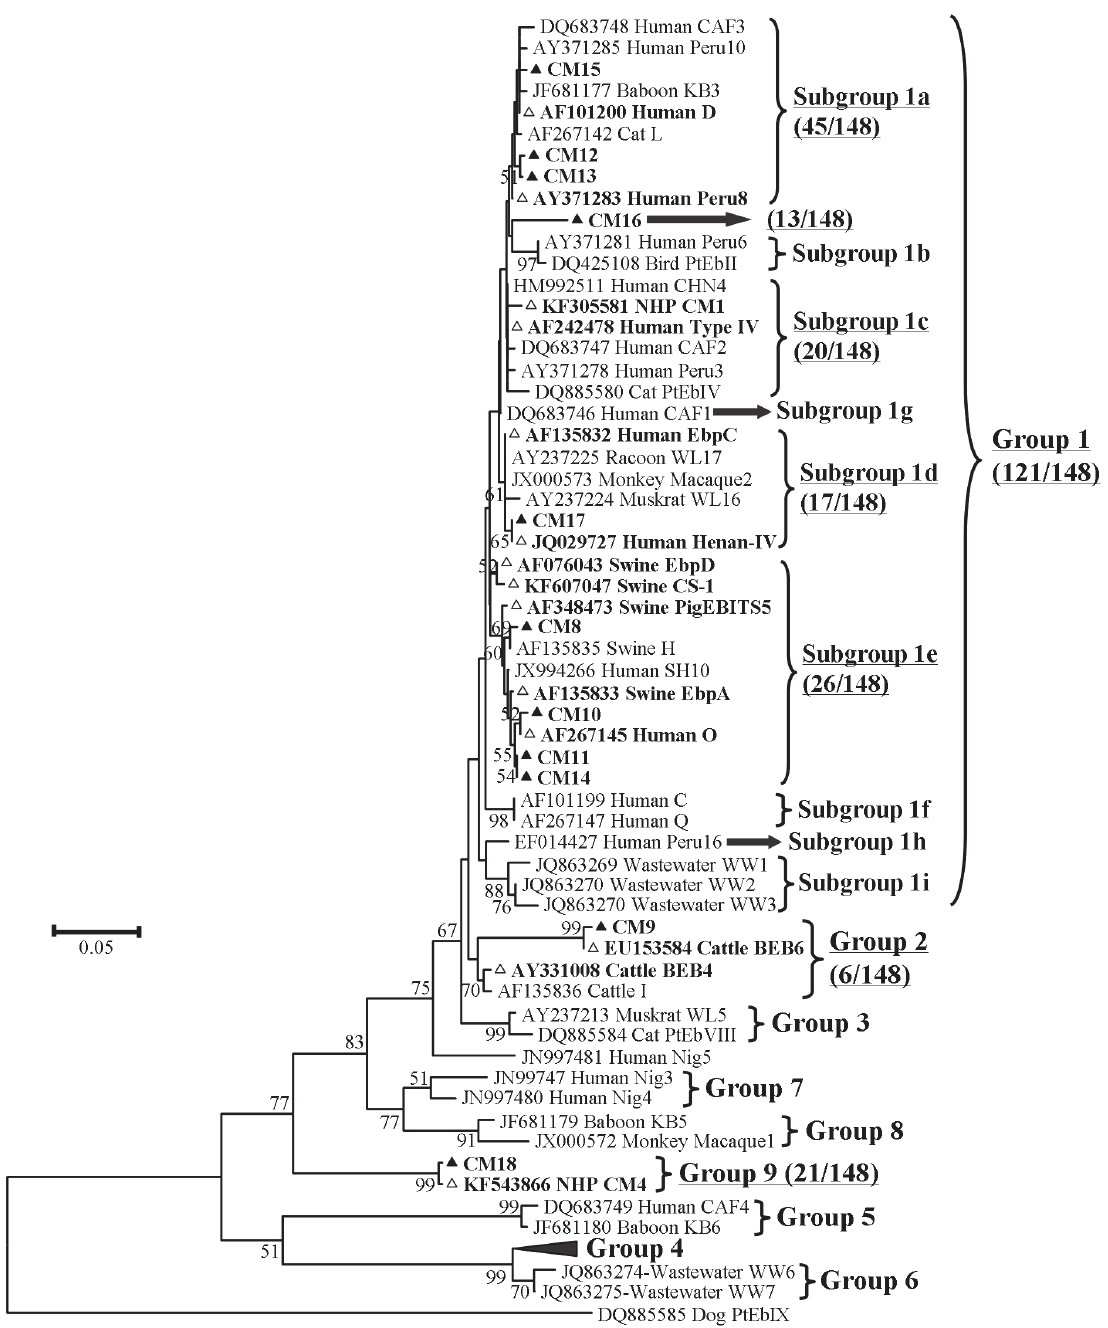
Fig 2. Neighbor-joining tree of E . bieneusi ITS genotypes. Phylogenetic relationship of E . bieneusi ITS nucleotide sequences of this study and other genotypes previously deposited in GenBank, as inferred by a neighbor-joining analysis (software Mega 5, http://www.megasoftware.net/) based on genetic distances calculated using the Kimura two-parameter model. The ITS tree was rooted with GenBank sequence DQ885585. Bootstrap values greater than 50% from 1,000 are shown on nodes. Each sequence from GenBank is identified by the accession number, host origin, and the genotype designation. The group terminology for the clusters is based on the works of Thellier and Breton [21], Li et al. [9], and Karim et al. [3]. Two unique sequences of new genotype CM18 and known genotype CM4 in this study are designated as group 9 sequences. Known and new genotypes identified in this study are indicated by open and filled triangles,